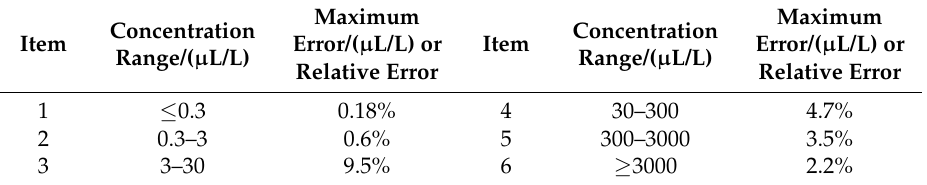
Table 3. Maximum testing error or relative error within different concentration